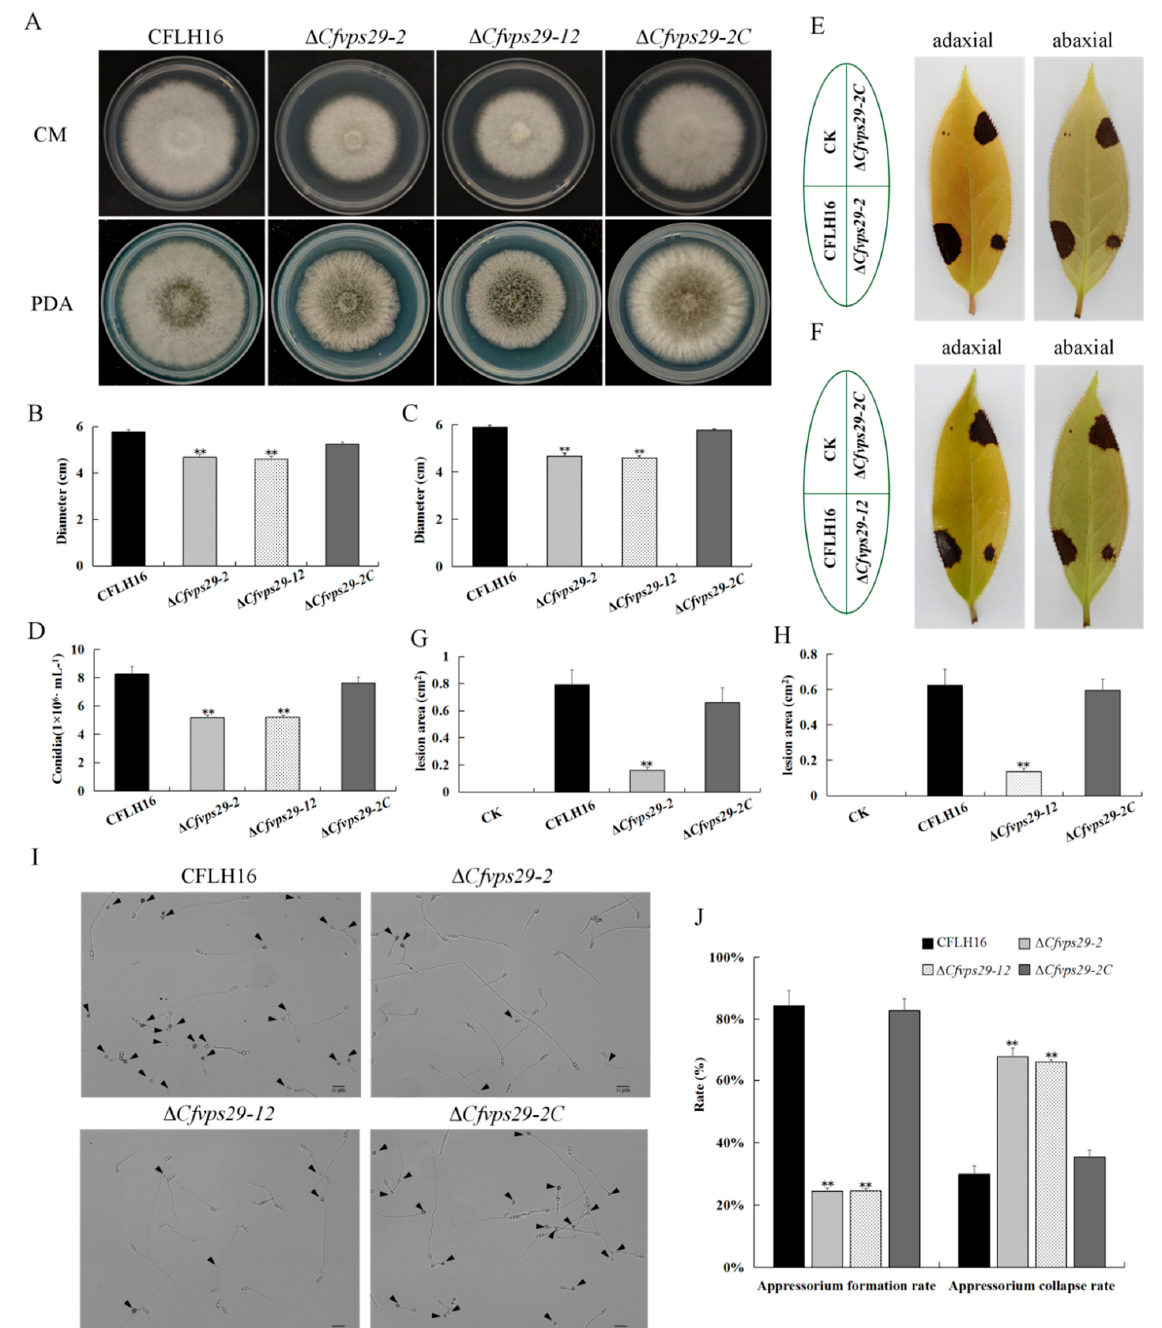
Figure 1. Phenotypic assays of the CfVPS29 deletion mutants. ( A ) The wild-type (CFLH16), Δ Cfvps29- 2, Δ Cfvps29- 12, and the complemented strain Δ Cfvps29-2C were inoculated on CM and PDA. ( B ) Statistical analysis of the colony diameter variations on CM. ( C ) Statistical analysis of the colony diameter variations on PDA. ( D ) Conidia were measured and statistically analyzed by Duncan analysis. ( E , F ) Pathogenicity test strain CFLH16, ∆ Cfvps29 , and Δ Cfvps29-2C on wounded oil-tea leaves, CK indicates the negative control. ( G , H ) Statistical analysis of the lesion sizes on wounded leaves. ( I ) Appressoria formation in the wild-type (CFLH16), Δ Cfvps29- 2, Δ Cfvps29- 12, and the complemented strain Δ Cfvps29-2C (black arrow: appressorium). ( J ) Statistical analysis of the formation rate and collapse rate of the appressorium. All experiments were carried out at least three times, and each treatment had three replicates. Error bars represent the standard deviation and asterisks represent significance at p < 0.01